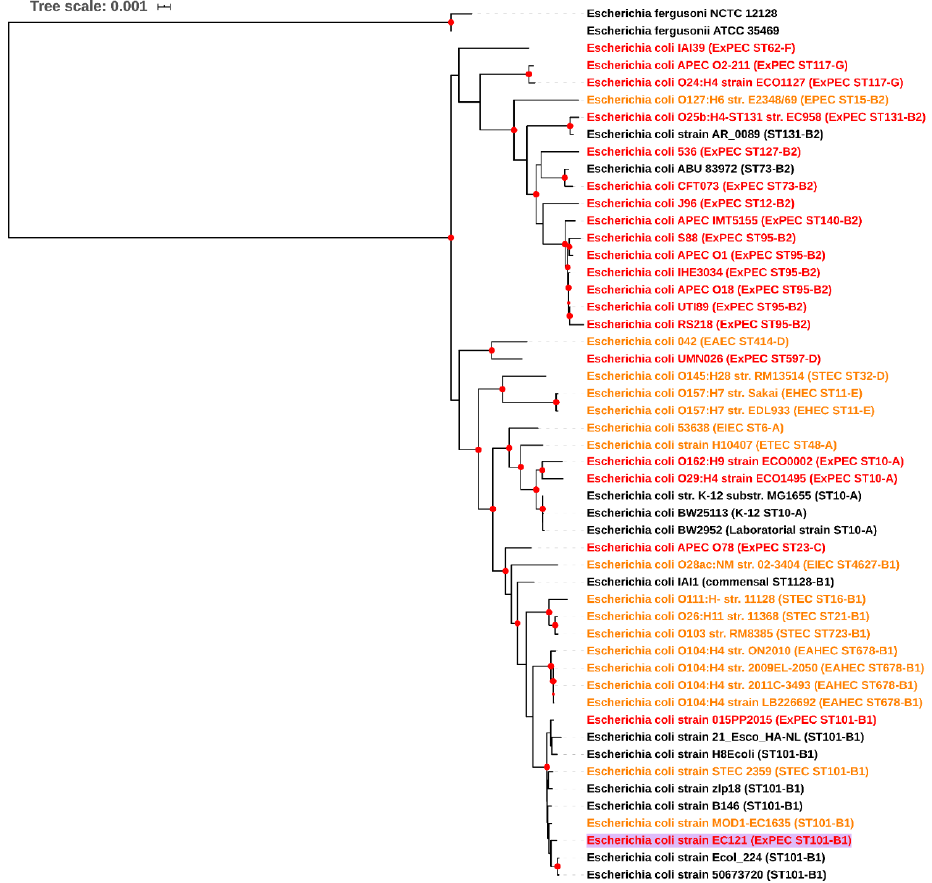
Figure 1. EC121 phylogenetic tree. A phylogenetic tree was built with genomes of reference Escherichia coli strains, of relevant pathogenic strains from all E. coli pathotypes, and some strains from ST101, using maximum likelihood-based algorithm (RA × ML) in PATRIC. In parenthesis, the strain pathotype (when known), the sequence type, and phylogroup, according to ClermonTyping [82], are depicted. The strains’ names are colored according to the following information: diarrheagenic E. coli strains are in orange; extraintestinal pathogenic E. coli strains in red; commensal, or strains with nonreported origin in black. In bold and with a lilac label background is the strain studied in present work. Bootstraps higher than 90 are denoted in the tree as red dots in the nodes.